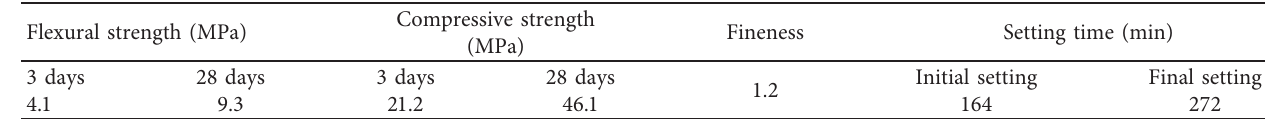
Figure 3: Particle size distribution and granular gradation of GT and sand: (a) particle size distribution; (b) granular gradation. Table 1: Mechanical properties of Portland cement (MPa).